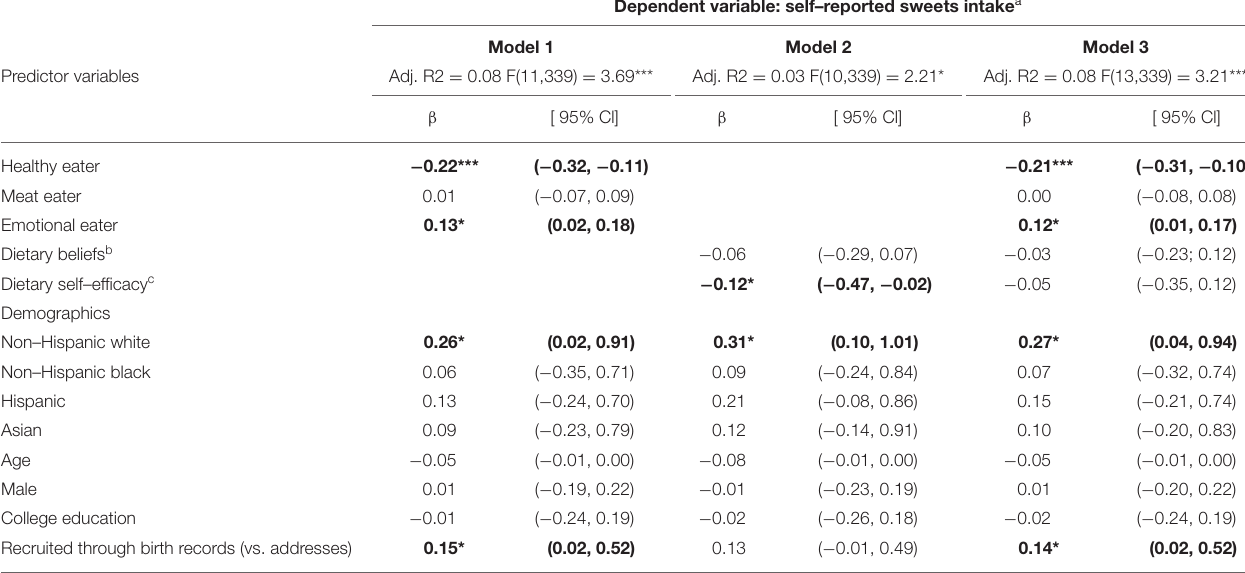
TABLE 6 | Linear regressions predicting self–reported sweets